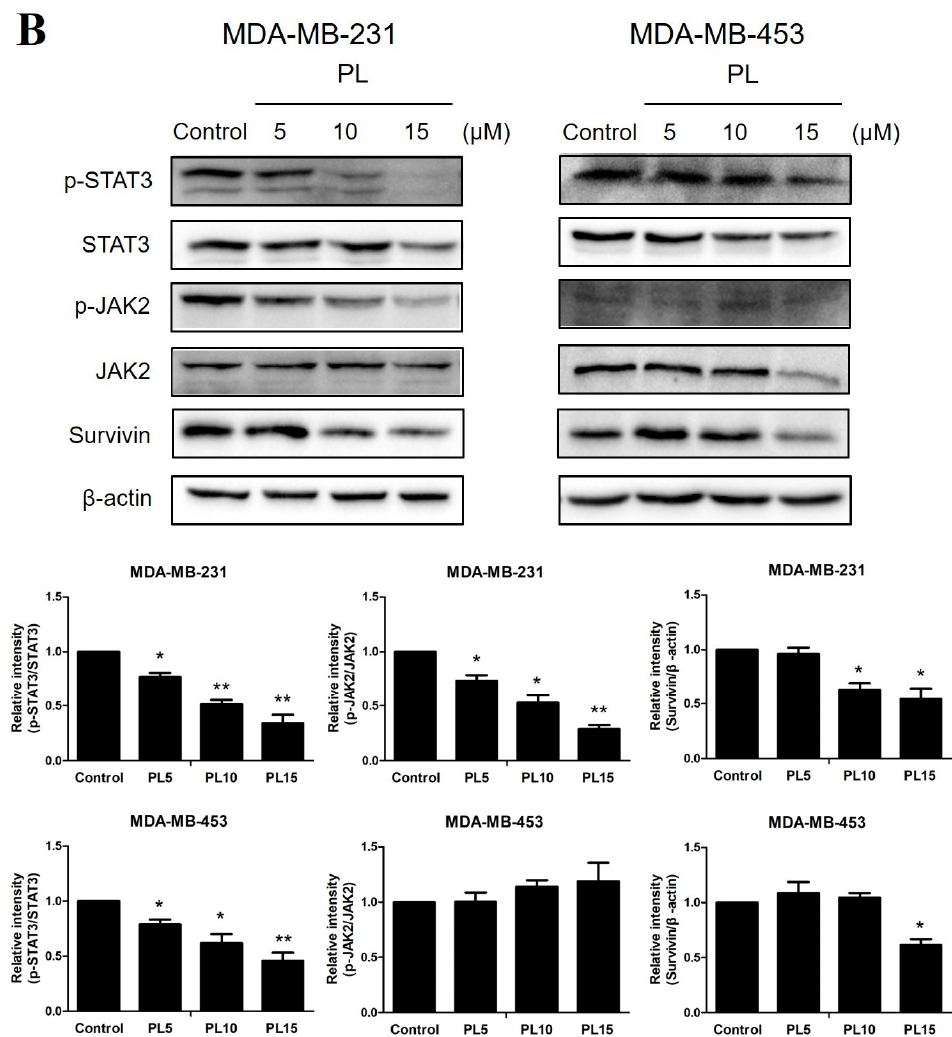
Figure 3. Piperlongumine downregulates Bcl-2 through inhibition of the JAK2-STAT3 pathway. ( A , B ) Both TNBC cell lines were treated with 5, 10, or 15 µ M PL, or DMSO as a vehicle control for 24 h. Cell lysates were then subjected to Western blot analysis. Apoptosis-related proteins, including Bcl-2, Bax, cleaved PARP, cleaved caspase-3, and p21, were detected. p-STAT3, STAT3, p-JAK2, JAK2, and survivin levels were then measured. β -actin was used as an internal control. * p < 0.05, ** p < 0.01, *** p <